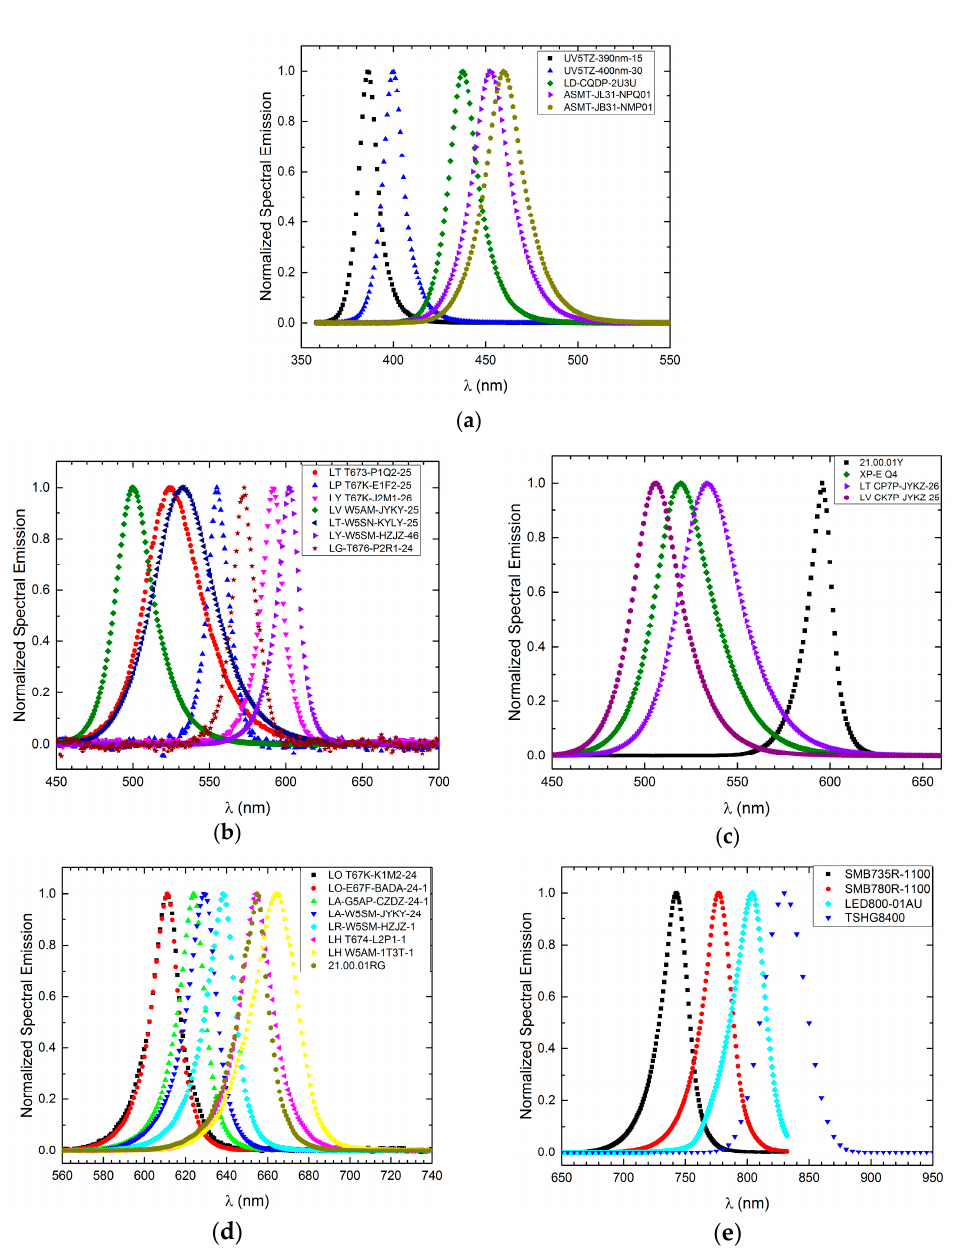
Figure 3. Examples from Table 1 of normalized emission spectra of LED sources with lambda peak ranging from: ( a ) 350 nm to 490 nm; ( b ) 490 nm to 650 nm (first group); ( c ) 490 nm to 650 nm (second group); ( d ) 600 nm to 700 nm; and ( e ) 700 nm to 830 nm.